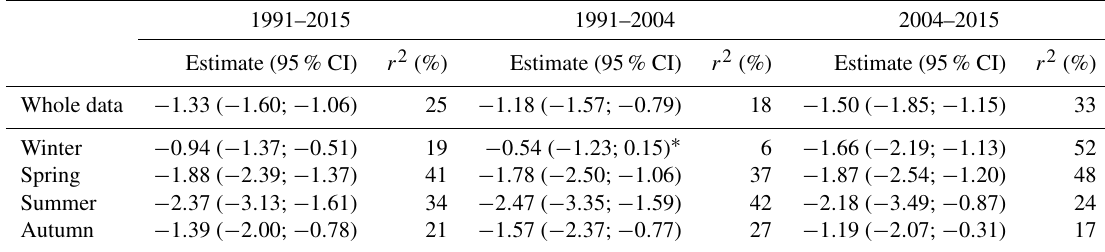
Table 4. Estimated effect of TO ozone on H er with 95% confidence intervals (CIs) based on three study